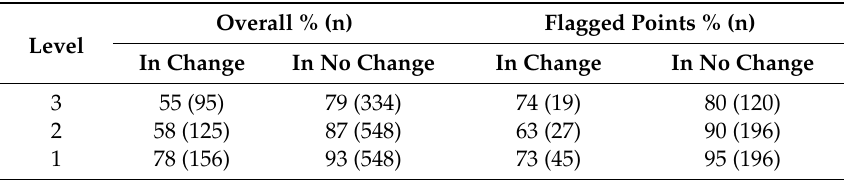
Table 3. LC percent agreement at di ff erent levels for all points and points flagged as potential high-quality, contrasting locations where change and no change was reported.